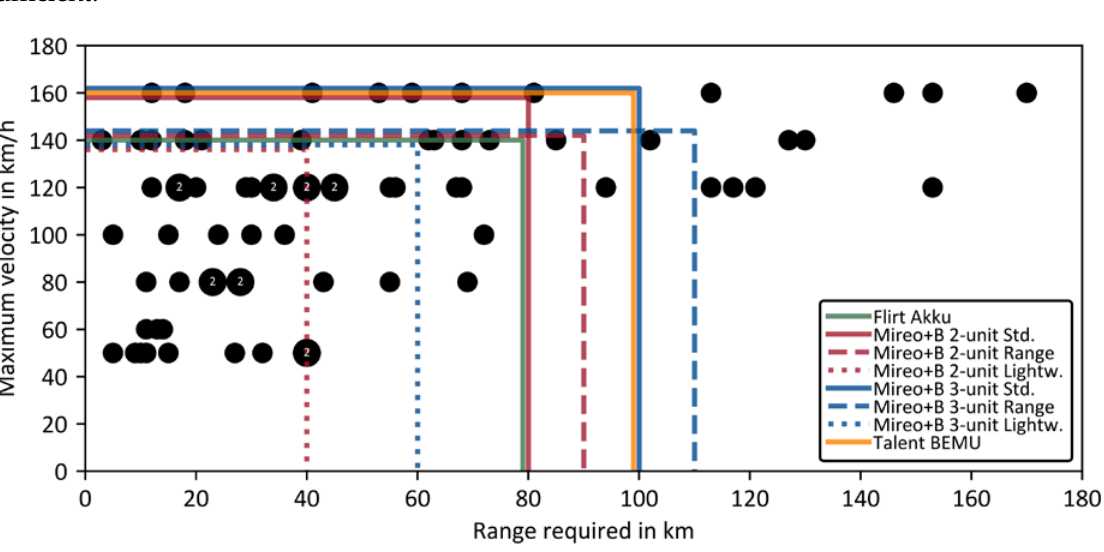
Figure 3. Lines' requirements for maximum speed and specific power with BEVs' performance envelopes. The size of the circle indicates the number of lines for each data